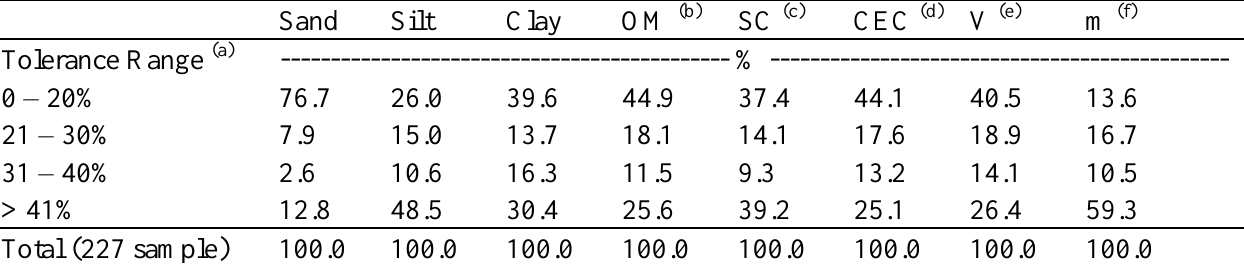
Table 8. Percentage of samples, results in the tolerance range, comparison between relative values (a) of laboratory traditional data (real value) and the values obtained by the satellite spectral data models.